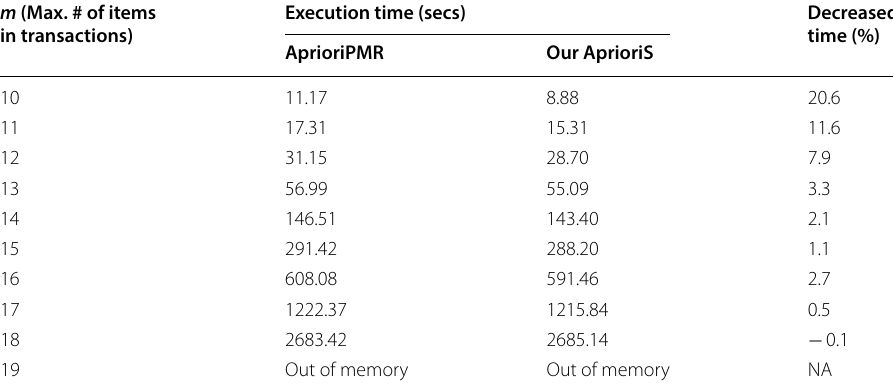
Table 4 Varying maximum number items in transactions m (Max. # of items in